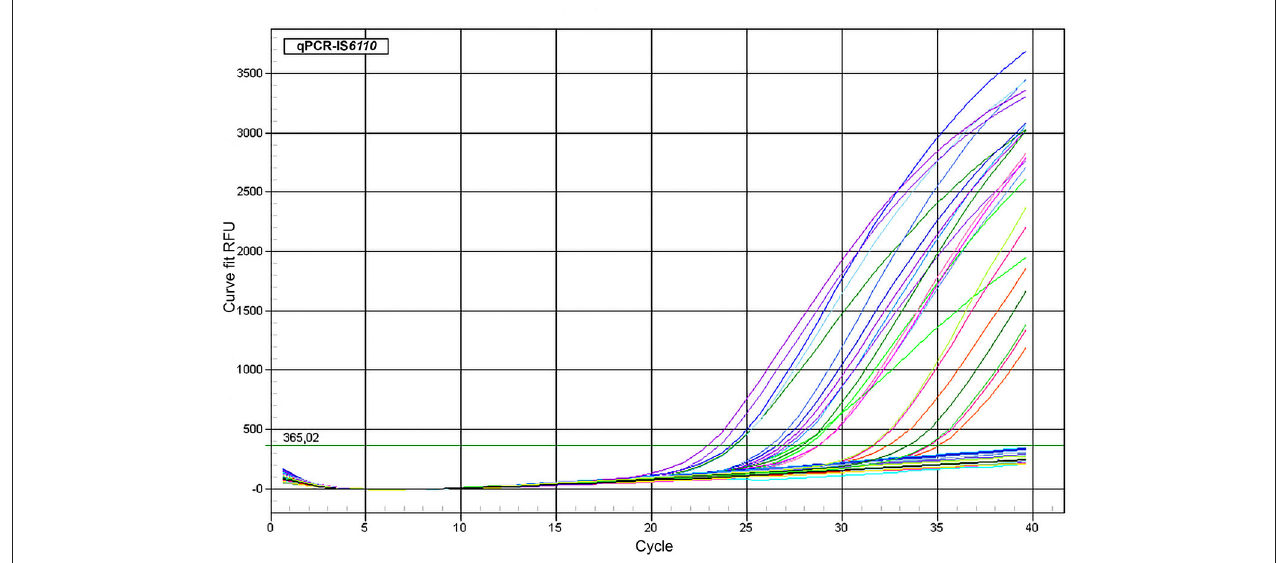
FIGURE 1 | Amplification plot of representative samples. qPCR targeting IS 6110 assay using representative fresh lymph node tissue samples belonging to different cattle. 1 RFU (Y axis) of the reaction was plotted against the Ct value (X axis). Samples with lowest DNA concentration could be detected ranging from 34 to 36 cycles